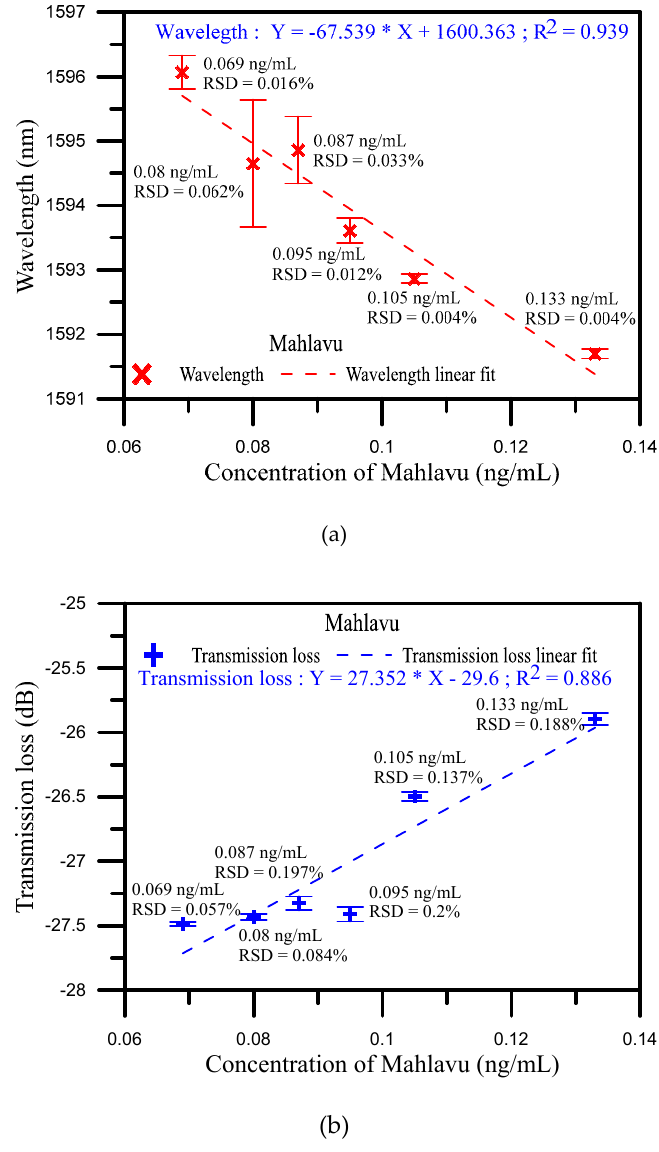
Figure 5. ( a ) Wavelength shift analysis diagram of Mahlavu specimen detection for the middle concentration area; ( b ) Transmission loss shift analysis diagram of Mahlavu specimen detection for the middle concentration area.